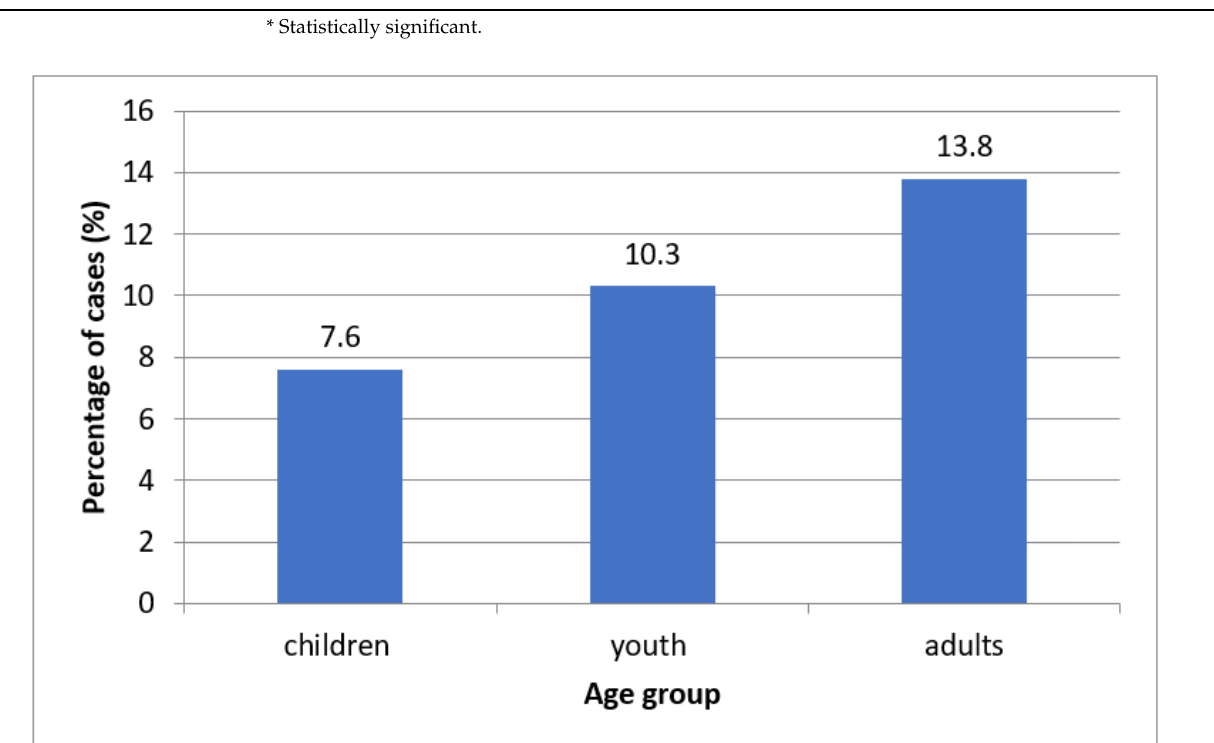
Figure 1. The frequency of positive HPV cases in the oral cavity of the studied groups. Children